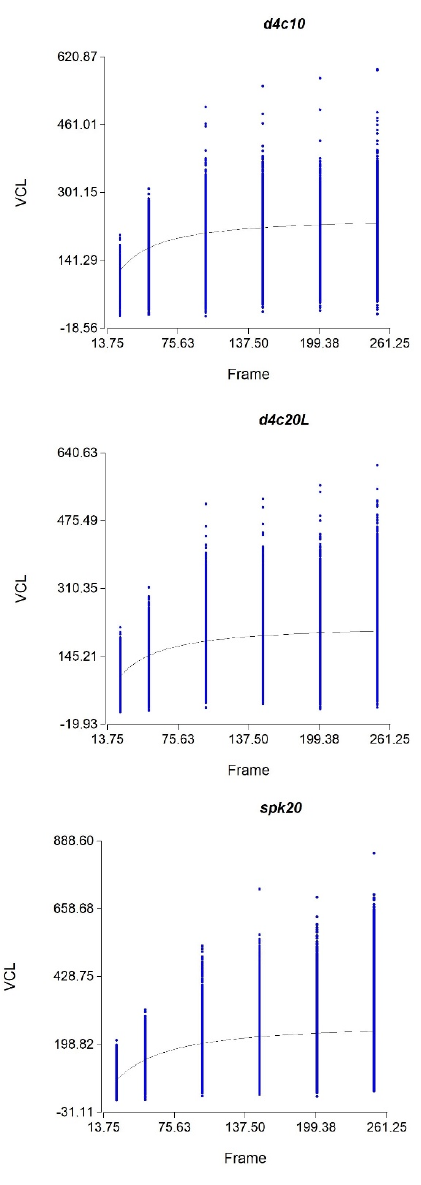
Figure 2. Sperm curvilinear velocity (VCL. µm/s) obtained at different frame rates in the different counting chambers.